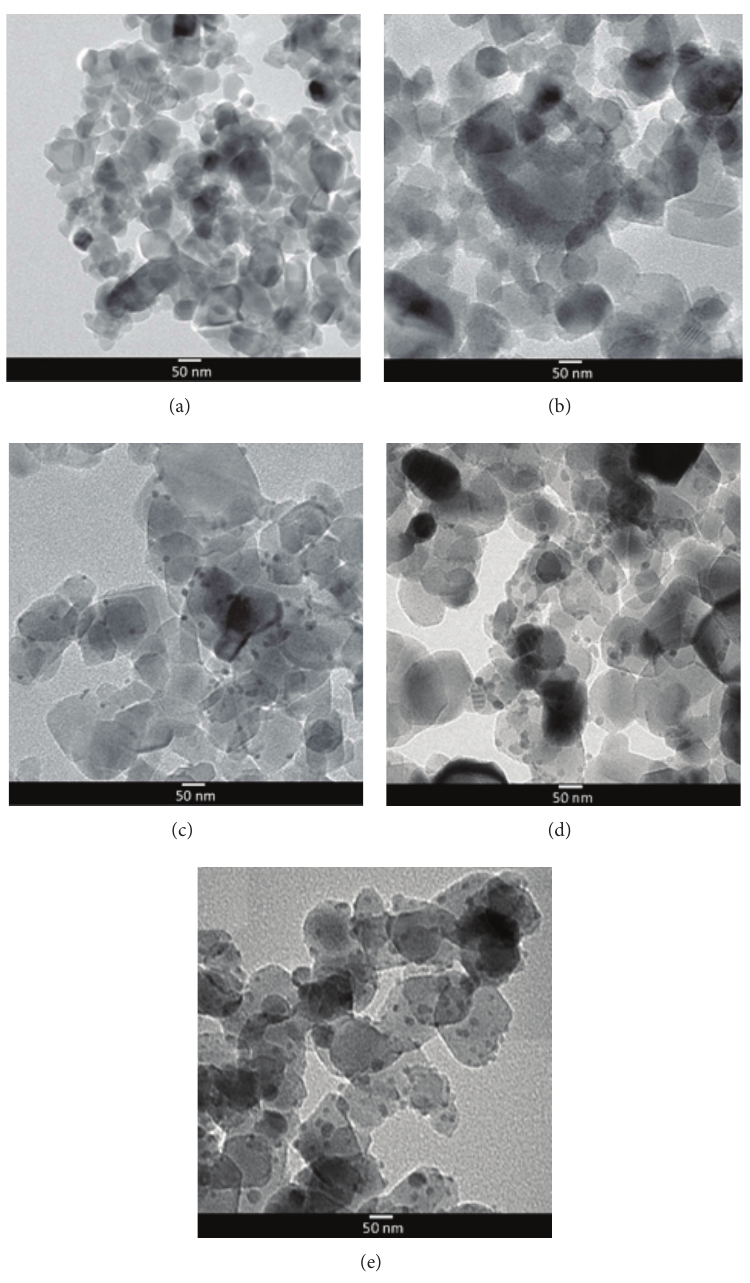
Figure 3: TEM images of ZrO 2 -SiO 2 (a), 0.1 Pt/ZrO 2 -SiO 2 (b), 0.2 Pt/ZrO 2 -SiO 2 (c), 0.3 Pt/ZrO 2 -SiO 2 (d), and 0.4 Pt /ZrO 2 -SiO 2